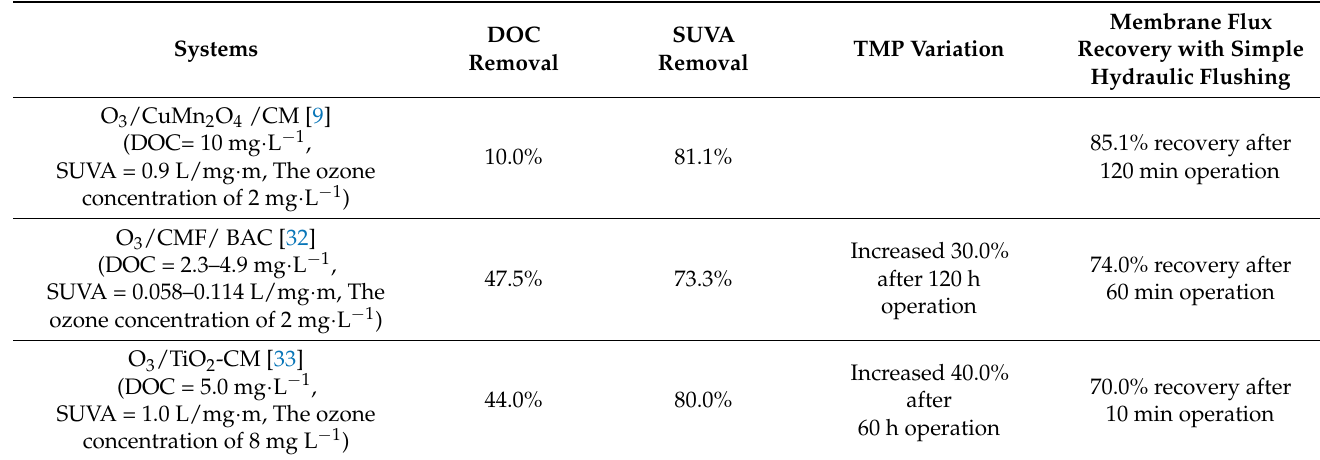
Figure S5: The water contact angle of (a) the original ceramic membrane and (b) the Mn-Fe-CM, Figure S6: N 2 Adsorption-Desorption Isotherm of (a) original ceramic membrane and (b) the